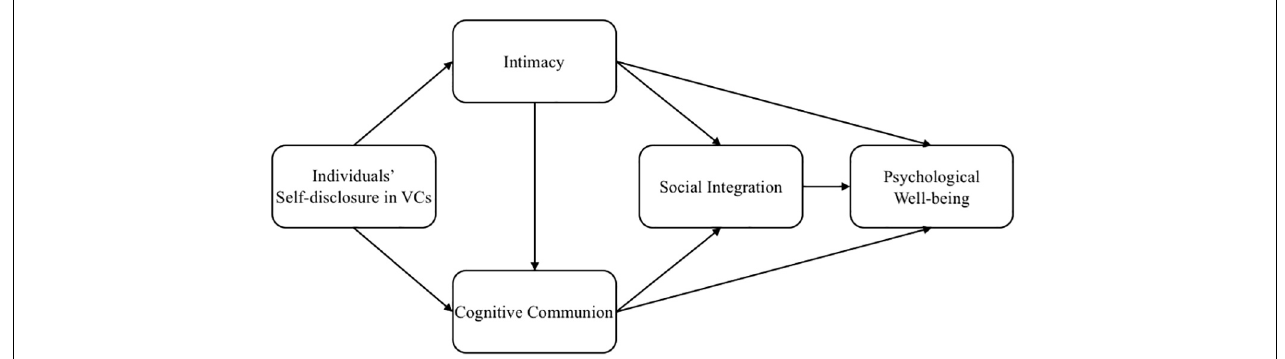
FIGURE 1 | Research